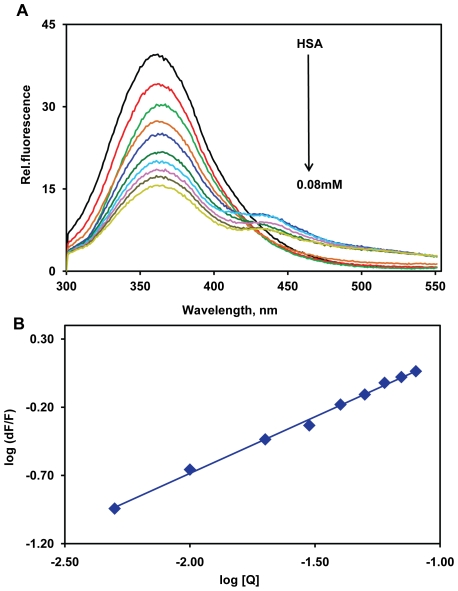
Fluorescence emission spectra of HSA–TMF in 0.1 M phosphate buffer pH 7.2, λex = 285 nm, temperature = 25±1°C.A) Free HSA (0.025 mM) and free HSA with different concentrations of TMF (0.005, 0.01, 0.02, 0.03, 0.04, 0.05, 0.06, 0.07, 0.08 mM). B) Plot of log (dF/F) against log [Q]. λex = 285 nm λem = 362 nm.